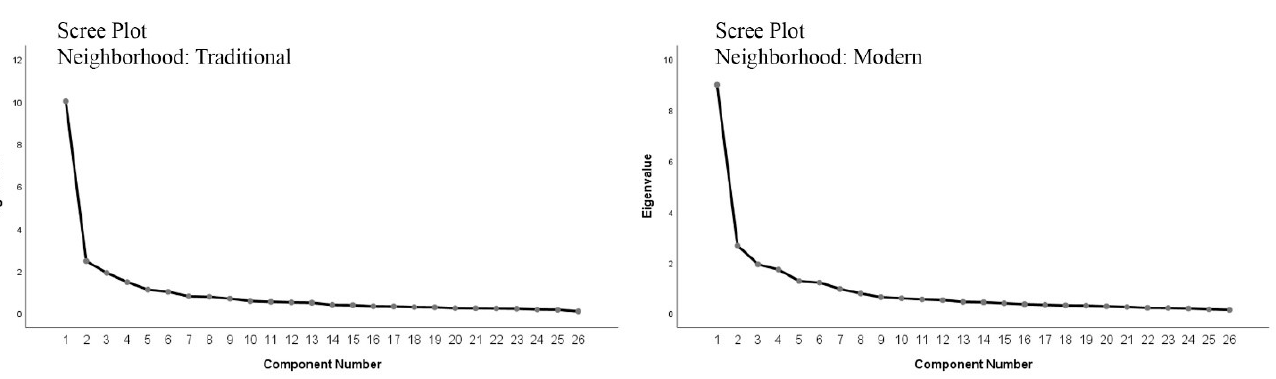
Figure 9. Scree plot of PCA, confirming the six latent variables.